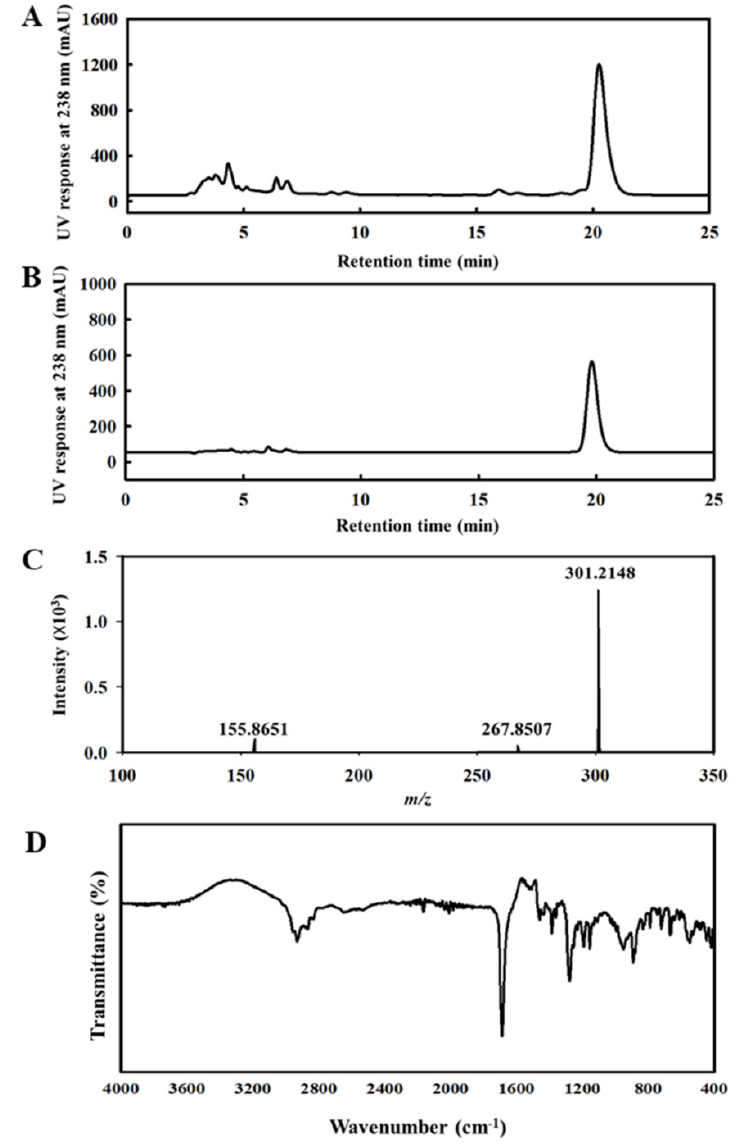
Figure 1. HPLC, LC-MS, and FTIR profile of AA. ( A ) HPLC chromatogram of rosin. ( B ) HPLC chromatogram of AA isolated and purified from rosin. ( C ) LC-MS spectra of AA. ( D ) FTIR spectra of AA. Abbreviations: HPLC, high-performance liquid chromatography; AA, abietic acid; LC-MS, liquid chromatography-mass spectrometry; FTIR, Fourier transform